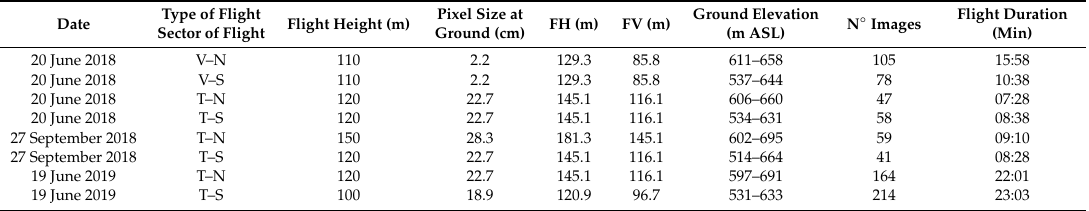
Table 3. Date of each measurement campaign; the type of flight if visible (V) or thermal (T) and relative sector of flight (N = North; S = South); the flight height and the relative parameters of the image that is pixel, horizontal field of view (FH), vertical field of view (FV), range of ground elevation, number of pictures and flight